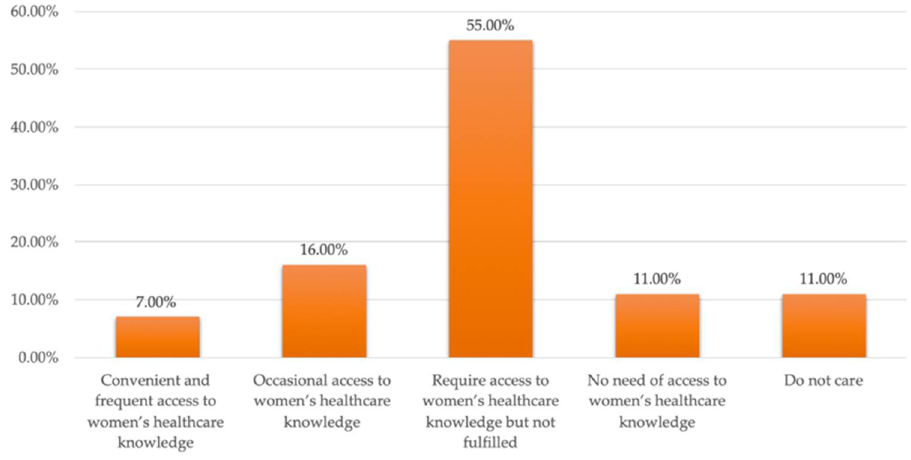
Figure 7. Women’s accessibility to healthcare knowledge.